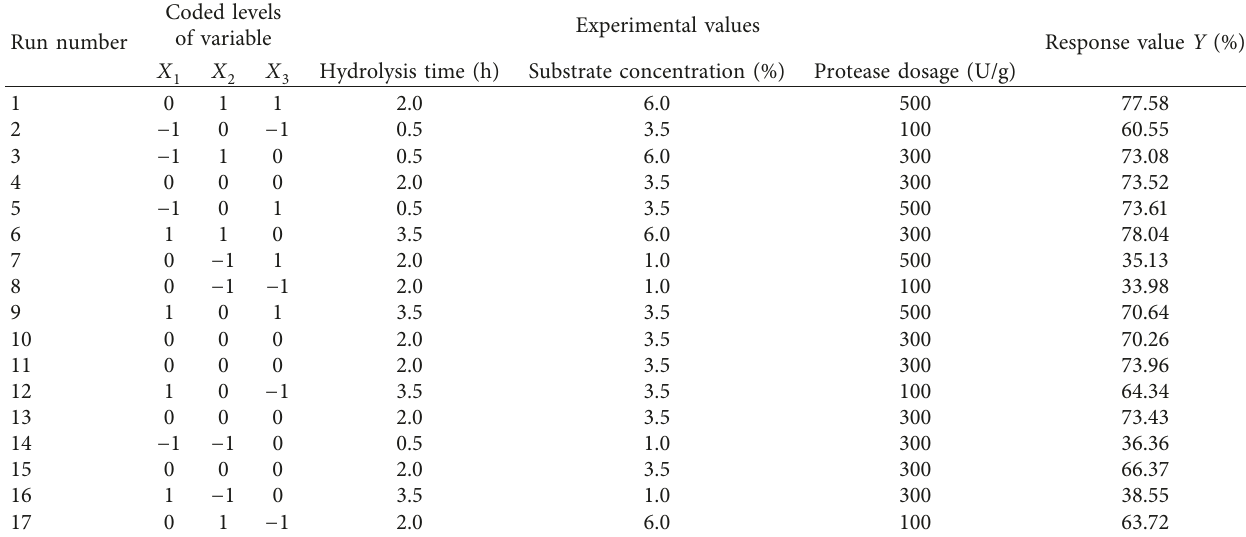
Table 2: The Box–Behnken design for optimizing hydrolysis conditions with DPPH radical-scavenging activity. Coded Run number